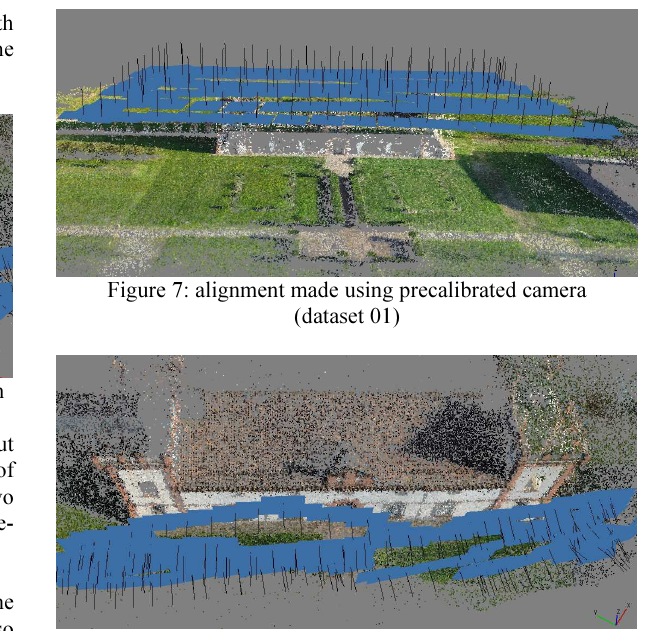
Figure 8: alignment made using precalibrated camera